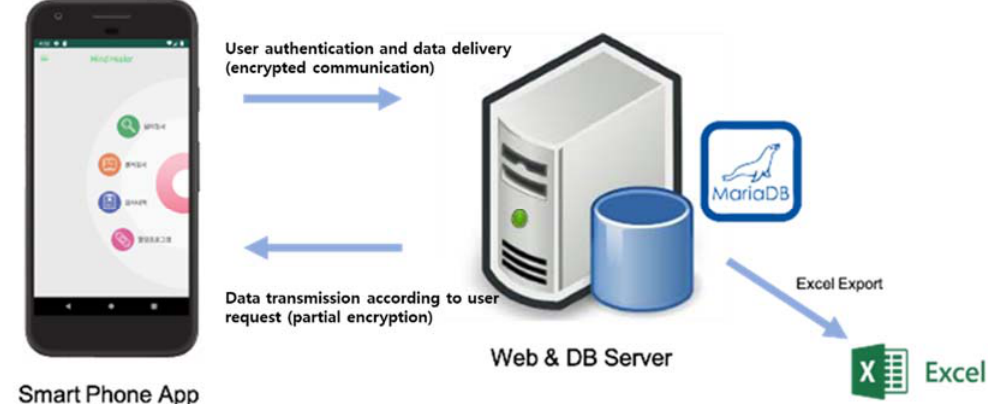
Figure 1. System configuration in database development environment.